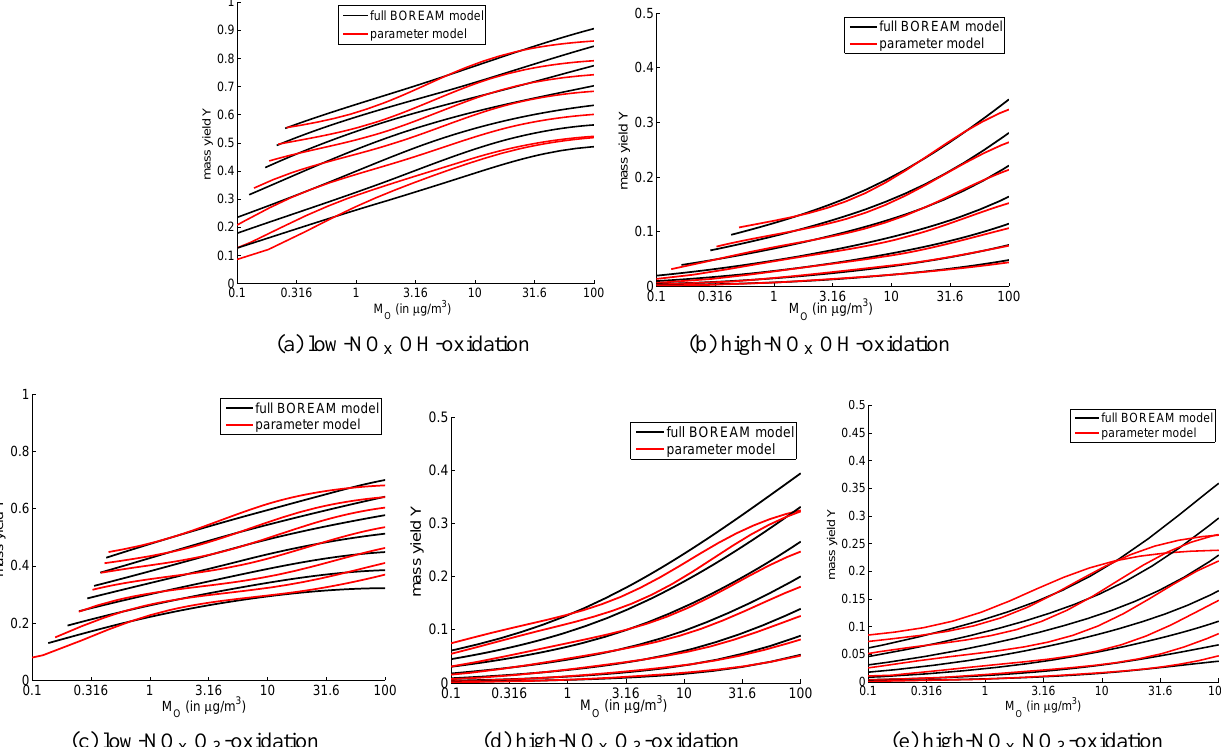
Fig. 5. Fitted (red) and full model (black) net equilibrium SOA mass yields as functions of the organic aerosol mass loading M O , for the low-NO x OH-oxidation scenario. The seven curves are obtained at temperatures ranging from 0 to 30 ◦ C, by steps of 5 ◦ C, the highest temperature corresponding to the lowest curve.